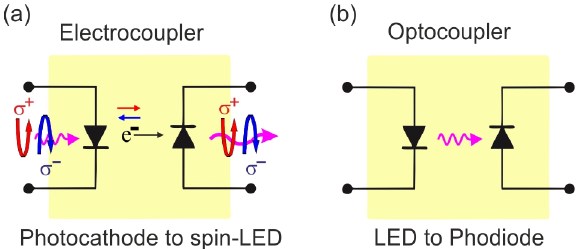
Figure 7. ( a ) Electrocoupler working principle. The electrocoupler can work in both current and optical modes. The optical mode ensures spin-dependent operation. ( b ) Optocoupler working principle. The optocoupler uses LED optically coupled to a photodiode (phototransistor) in a single package.